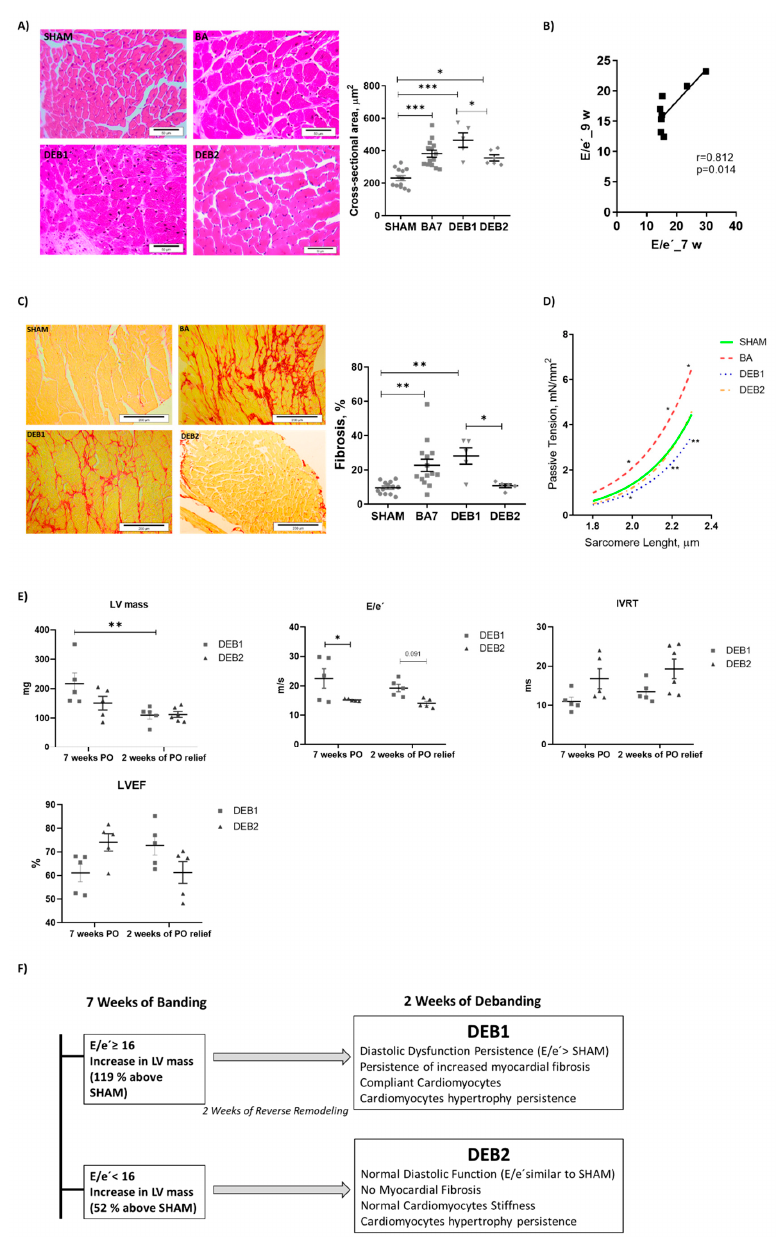
Figure 1. Cardiomyocytes sectional area and representative images of Haematoxylin-eosin-stained sections from (SHAM n = 13), BA ( n = 14), DEB1 ( n = 5) and DEB2 ( n = 6) groups ( A ). Pearson correlation between E / e’ before debanding (E / e’ _7w) and after two weeks of debanding (E / e’ _9w) from both DEB1 and DEB2 animals ( B ). Left Ventricular interstitial fibrosis and representative images of Red Sirius-stained sections from SHAM ( n = 17), BA ( n = 13), DEB1 ( n = 4) and DEB2 ( n = 6) groups ( C ). Cardiomyocytes sti ff ness assessed by passive tension-sarcomere length relation (number of cells: SHAM, n = 49; BA, n = 51; DEB1, n = 13, DEB2, n = 17) ( D ). Echocardiographic characterization of DEB1 and DEB2 subgroups before debanding-induced reverse remodelling (RR) (seven weeks of banding) and after two weeks of cardiac RR ( E ). Summary of phenotypic findings for debanding subgroups ( F ). E / e’, the ratio of mitral peak velocity of the early filling ( E ) to early diastolic mitral annular velocity (e’); IVRT, isovolumetric relaxation time; LVEF, left ventricle ejection fraction; LV mass, left ventricle mass; PO, pressure overload. Values are represented as mean ± SEM. One-Way-ANOVA followed by Holm Sidak’s test for variable fibrosis and CSA. Kruskal-Wallis test for sarcomere length relation. Mixed-e ff ects analysis for echocardiographic variables over time in groups DEB1 and DEB2. vs. SHAM *, p < 0.05; **, p < 0.01; ***, p <